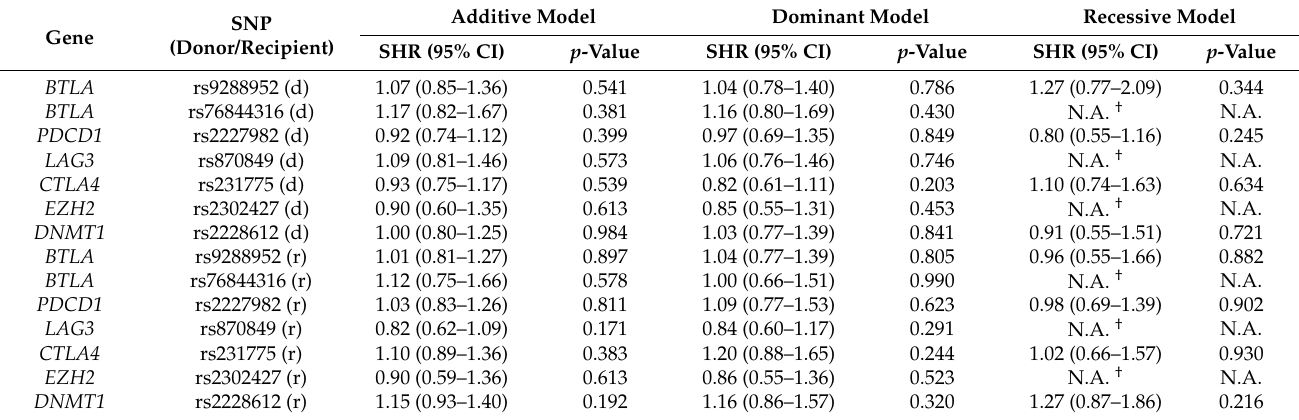
Table 6. Multivariable regression of non-relapse mortality (NRM) on donor and recipient SNPs.